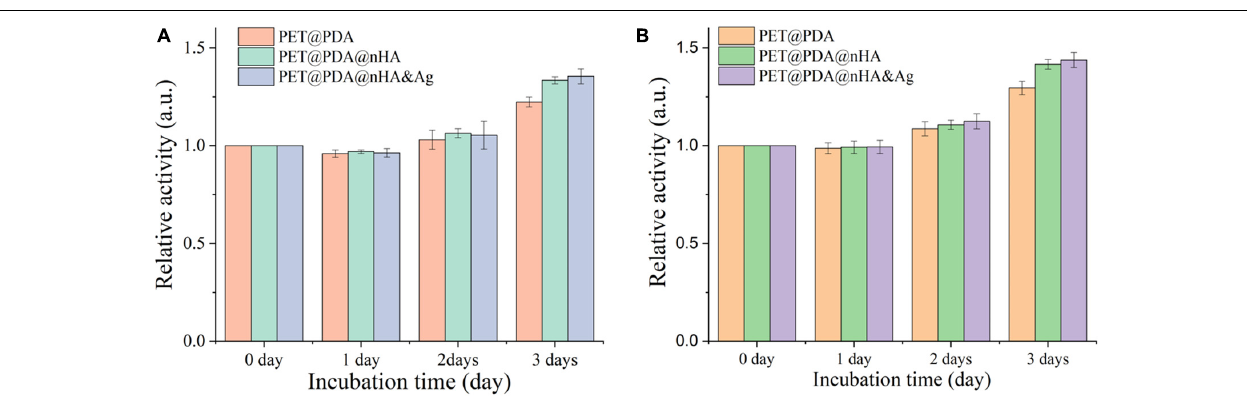
FIGURE 9 | (A) NIH3T3 and (B) MG-63 cell proliferation of three kinds of